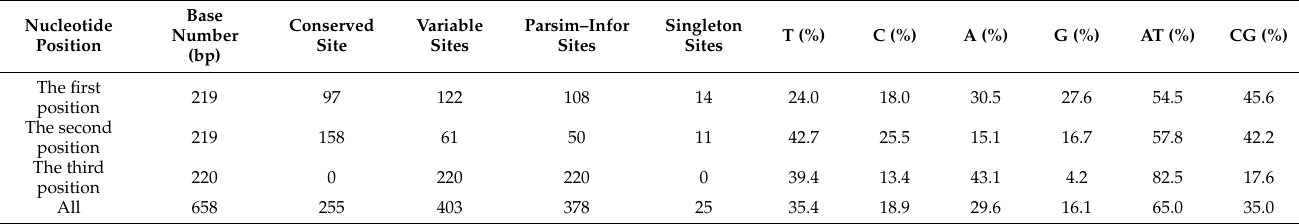
Table 3. Nucleotide composition in the 648 COI barcoding